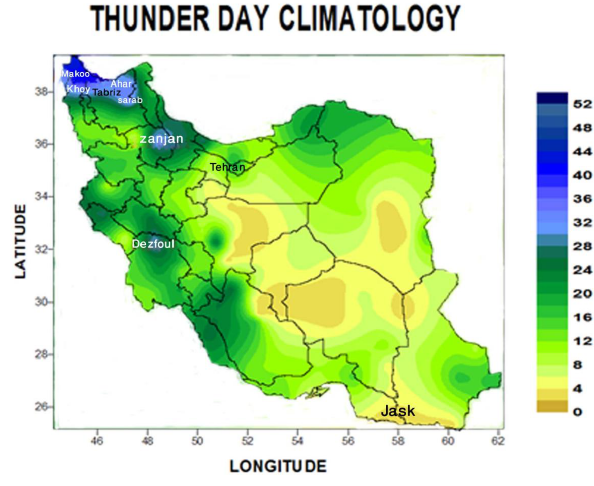
Fig. 1. Geographical position of Iran